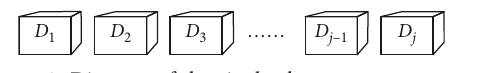
Figure 3: Diagram of the single chromosome structure.